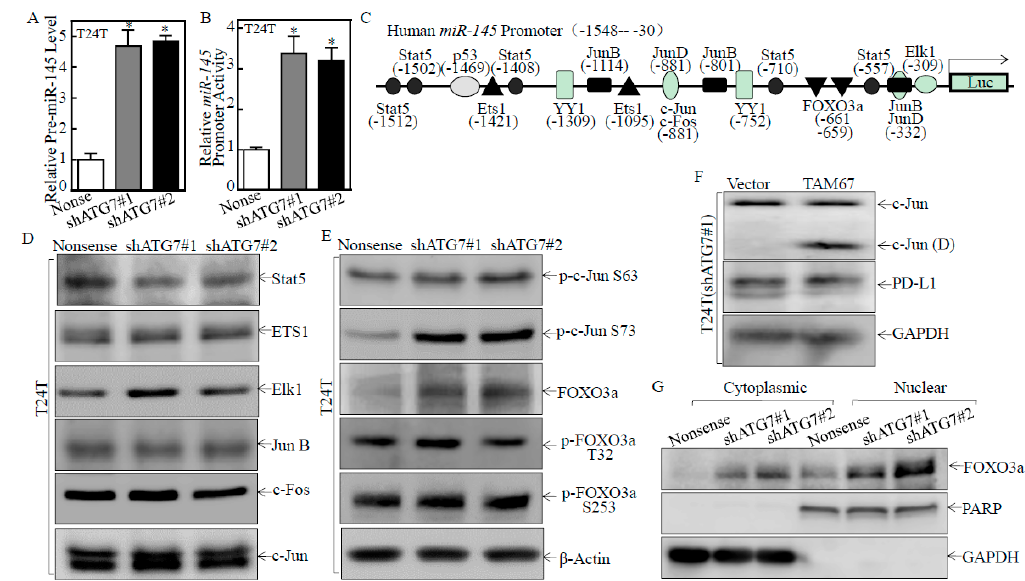
Figure 4. ATG7 overexpression inhibited miR-145 mRNA transcription in human BC cells. ( A , B ) Pre-miR-145 expression and miR-145 promoter transcription activity were evaluated in the indicated cells, the symbol (*) indicates a significant increase in comparison to scramble Nonsense transfectant (* p < 0.05). ( C ) Potential transcriptional factor binding sites in the miR-145 promoter region (–1548 to –30) were analyzed by using the TRANSFAC 8.3 engine online. ( D , E ) The indicated cell extracts were subjected to Western Blot for determination of the expression of Stat5, ETS1, Elk1, JunB, c-Jun, p-c-Jun S63, p-c-Jun S73, FOXO3a, p-FOXO3a T32, and p-FOXO3a S253. β -Actin was used as a protein loading control. ( F ) Cell lysates extracted from T24T(shATG7#1/Vector) and T24T(shATG7#1/TAM67) cells were analyzed by Western Blot with a specific anti-c-Jun(D) antibody. ( G ) The indicated cell extracts were used to isolate cytoplasmic and nuclear fractions according to the protocol of the nuclear/cytosol fractionation kit. The isolated protein fractions were subjected to Western Blot. GAPDH and PARP were used as a control for cytosol or nuclear protein loading, respectively.